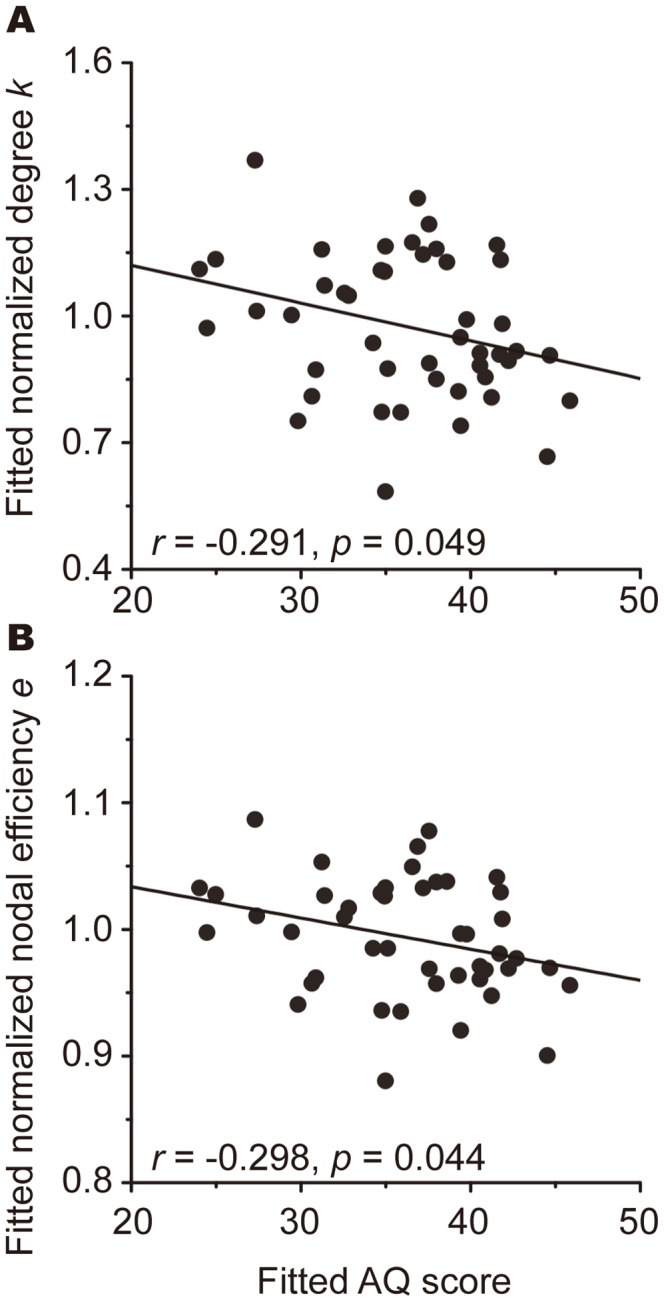
Scatter plots of degree and nodal efficiency of the left ACC against AQ score.Partial correlation analyses revealed that there were the significant negative correlations between the AQ score and two of the local metrics of the ACC (k: r = −0.291, p = 0.049; e: r = −0.298, p = 0.044).